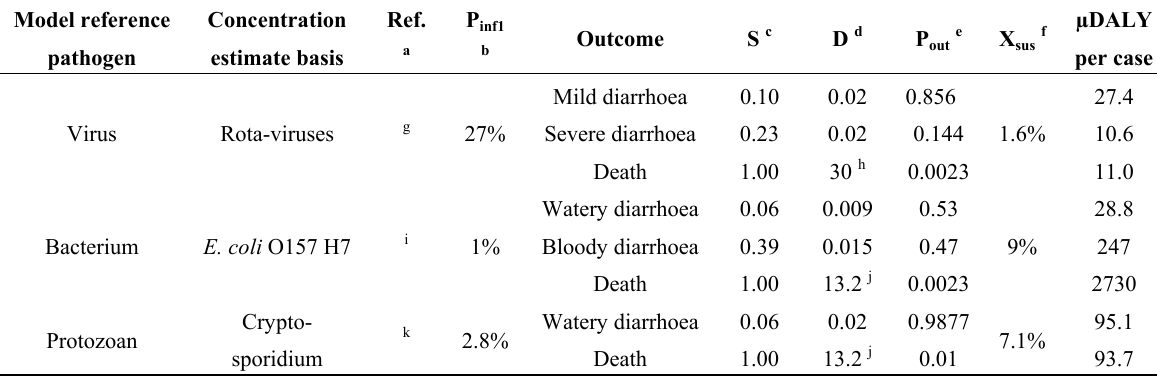
Table 2. Microbial dose-response data based upon literature cited by Howard [10] and µDALYs per reference pathogen microbial infection after Havelaar and Melse